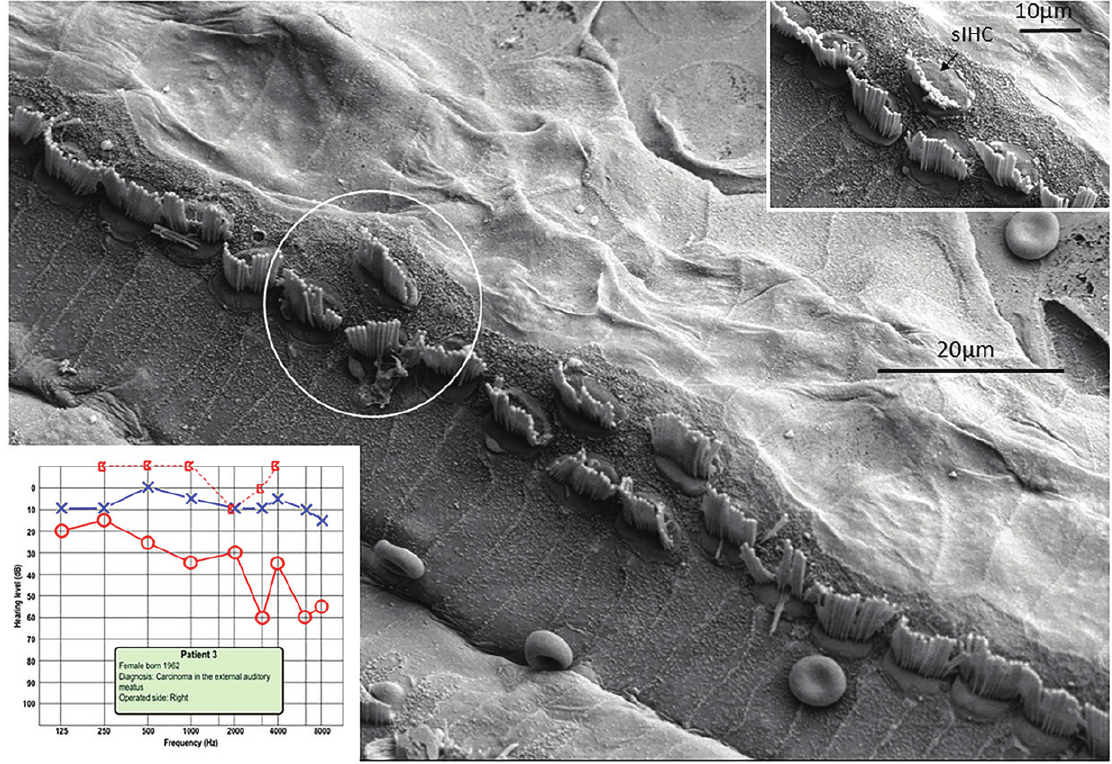
Figure 7. FESEM of the IHC region at the second turn of the human cochlea (patient 3). Sensorineural hearing is normal, with a minor conductive loss due to a carcin- oma of the external auditory canal. The IHCs are not well aligned. Several sIHCs are located at the modiolar side (arrows). Microvilli-rich border cells surround the sIHCs (inset). The surface of the inner sulcus is smooth. Some IHC stereocilia are not arranged in straight lines parallel to the long axis of the cochlear duct